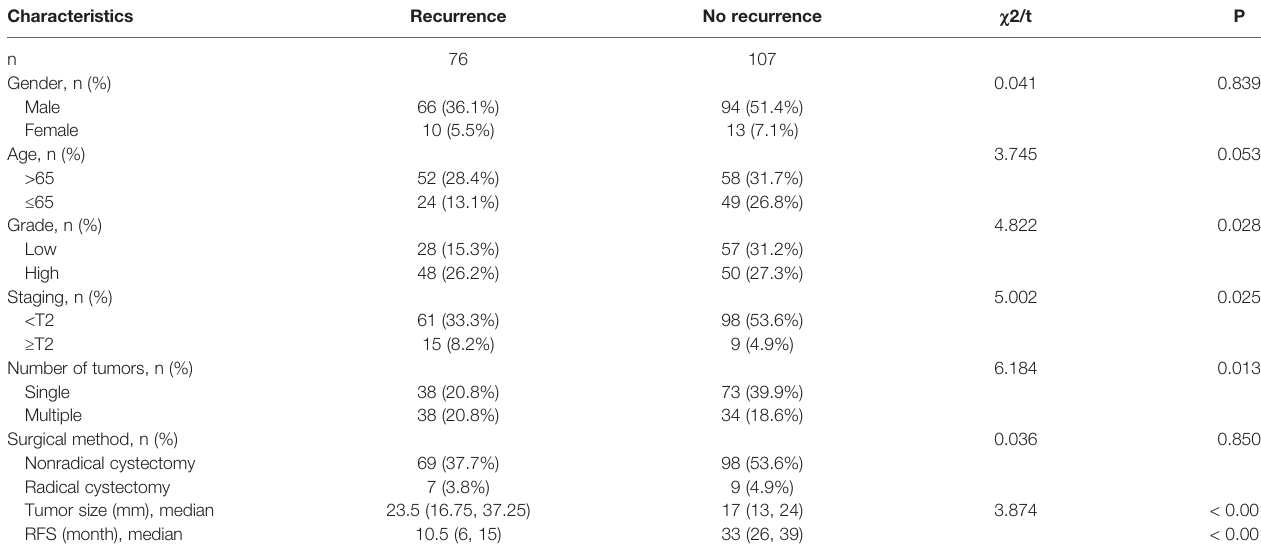
TABLE 1 | Comparison of clinical data between the recurrence group and no recurrence group. Characteristics